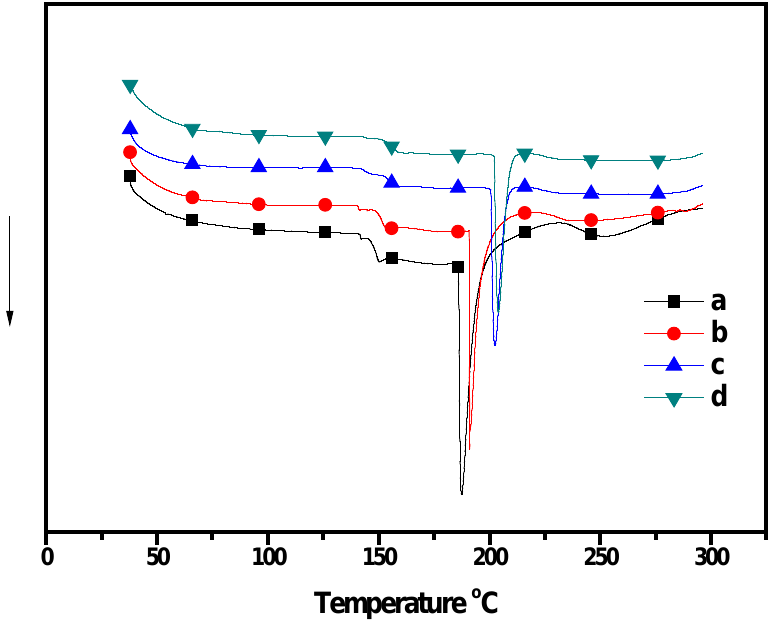
Figure 5. DSC thermogram of composites having: ( a ) only CP, ( b ) 1:0.5 CP/PU, ( c ) 1:1 CP/PU, and ( d ) 1:1 CP/PU with 10 wt% curcumin.